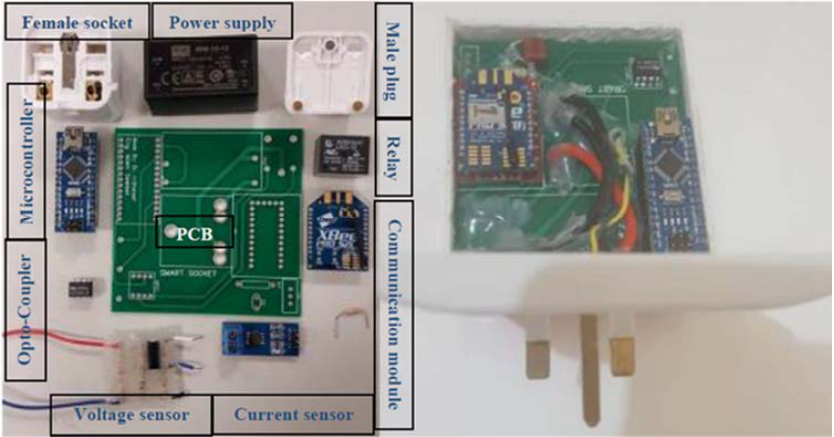
Figure 3. Smart plug/socket: components and prototype.